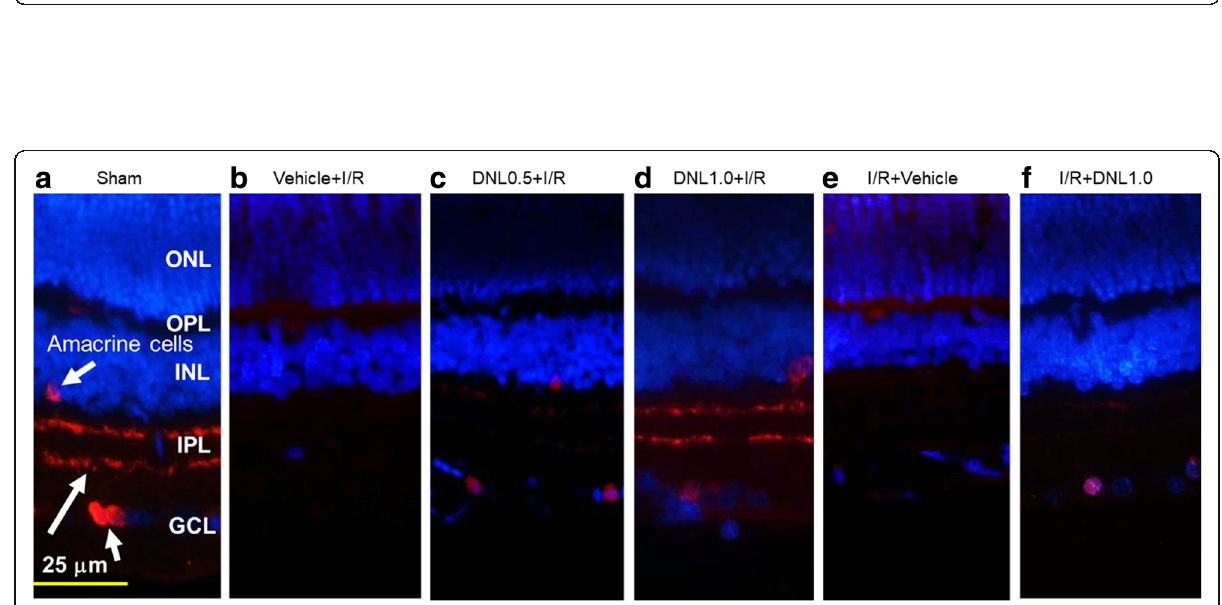
Fig. 5 Fluorogold labeling. The micrographs shows the retinal ganglion cell (RGC) density after the sham procedure ( a , Sham), or after ischemia followed by reperfusion (I/R) plus pre-ischemia administration of vehicle ( b , Vehicle+I/R) or pre − /post-ischemia administration of DNL at 1.0 g/kg/day ( c , DNL1.0+I/R; d , I/R+DNL1.0). The RGC density was quantitatively analyzed ( e ). As indicated by each bar, the results were means±S.EM. ( n =4). ** indicates a significant difference from the sham retina ( P <0.01; Sham vs. Vehicle+I/R); †† or † indicates a significant difference from the Vehicle+I/R ( P <0.01 or P <0.05; Vehicle+I/R vs. DNL1.0+I/R or I/R+DNL1.0). DNL, Dendrobium nobile Lindley. Scale bars =50 μ m